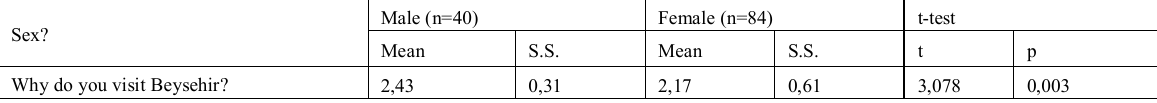
Table 5: Analysis of Effect of Gender on visiting Beysehir